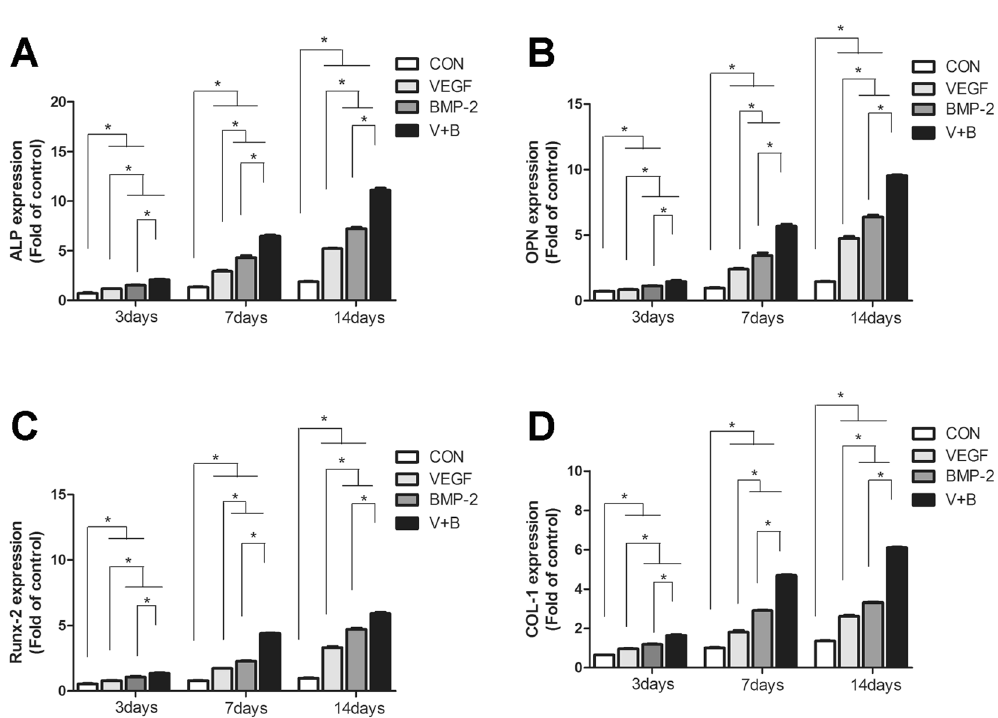
Figure 4. The ALP ( A ), COL I ( B ), Runx-2 ( C ) and OPN ( D ) gene expression of MC3T3 cells cultured on hydrogels of control, V, B and VB